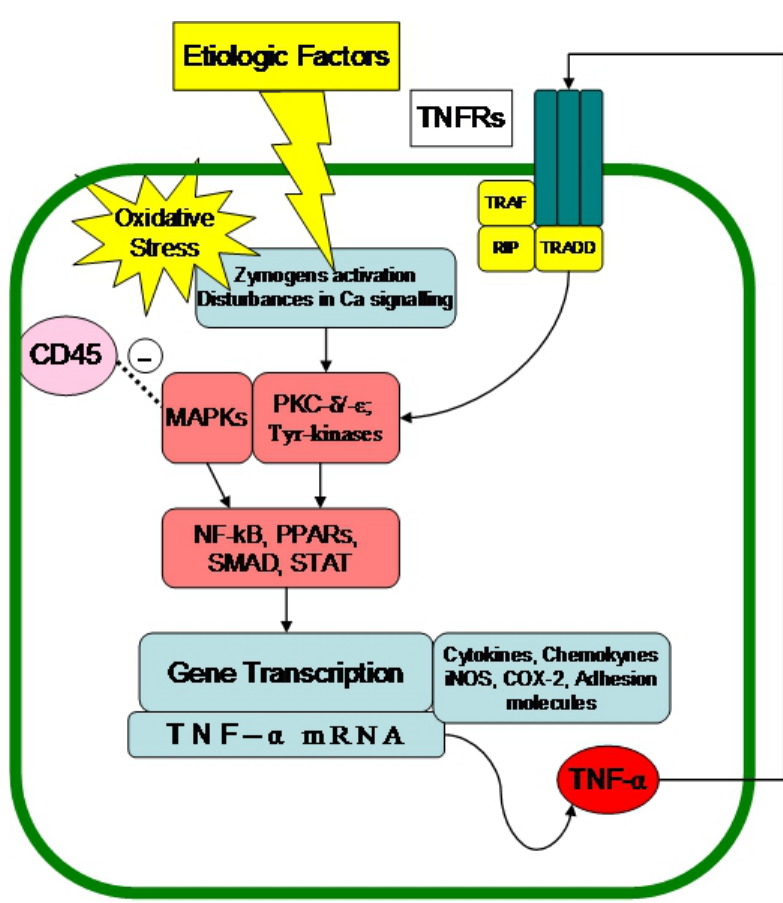
FIGURE 1 . Model of TNF- α production in acinar cells during pancreatitis. A kinases cascade triggered by disturbances in cell homeostasis activates a number of transcription factors, such as NF-kB, thereby leading to TNF- α up-regulation. CD45, formerly a leukocyte-specific glycoprotein, may have a role in negative regulation of TNF- α production through MAPK silencing. An overproduction of TNF- α enhances the inflammatory response via interactions with its specific receptors and recruitment of different adaptor proteins. Tyr-Kinases = tyrosine kinases; MAPK = mitogen activated protein kinases; TNFRs = TNF receptors; NF-kB = nuclear factor kB; PPARs = peroxisome proliferator − activated receptors; TRAF = TNF receptor − associated factor; TRADD = TNF receptor − associated death domain; RIP = receptor interacting